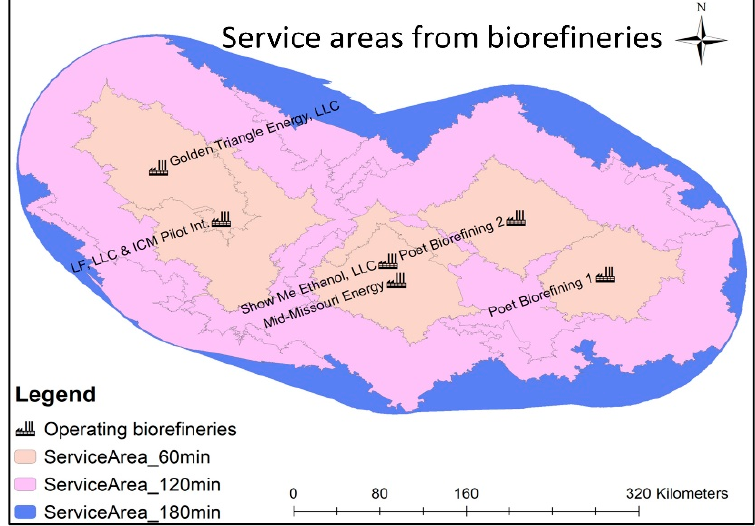
Figure 4. The service area of existing biorefineries within specific travel times.